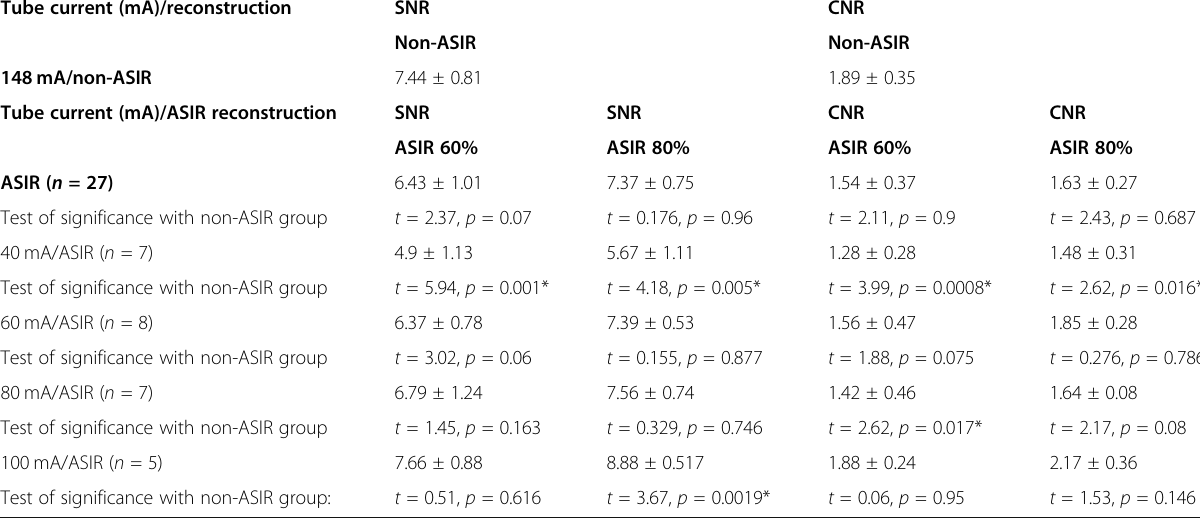
Table 4 Comparison of quantitative image analysis data of the ASIR and non-ASIR groups Tube current (mA)/reconstruction